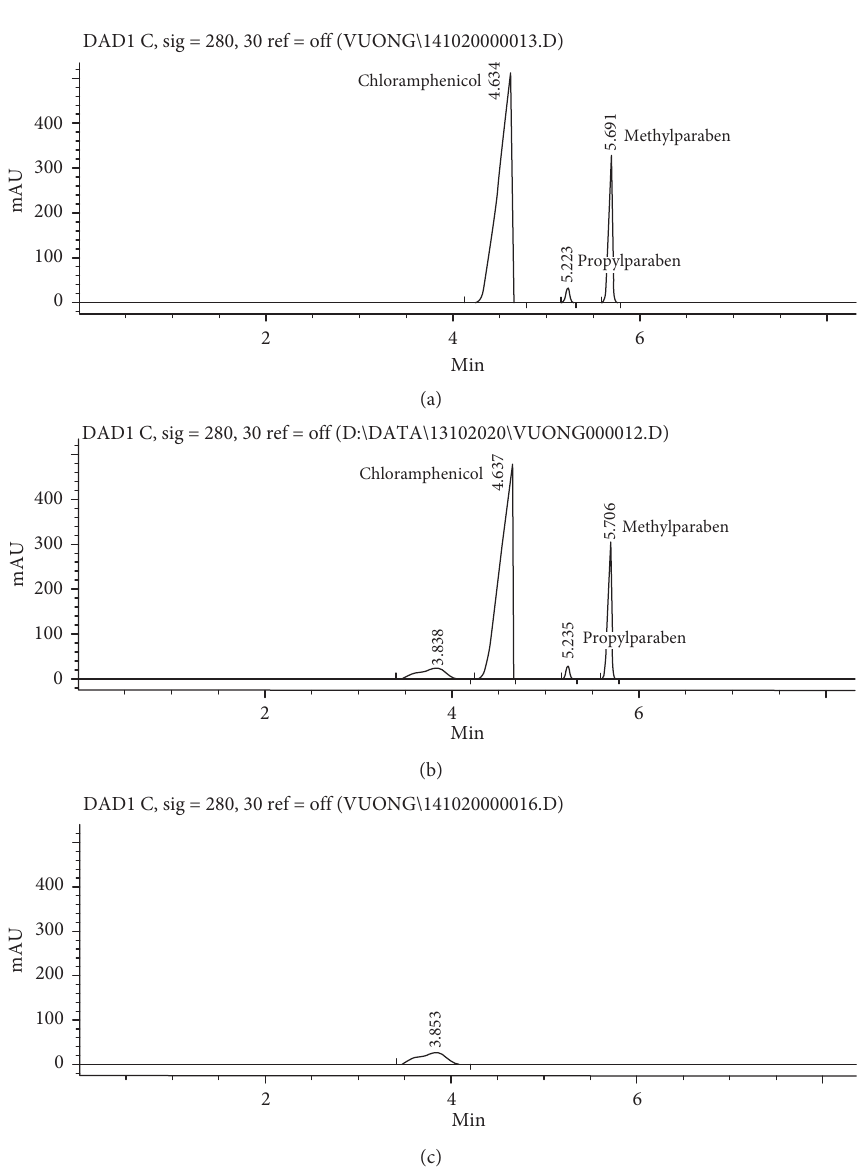
Figure 6: Typical electropherograms of mixed standard solution (a), eye-drops (b), and placebo